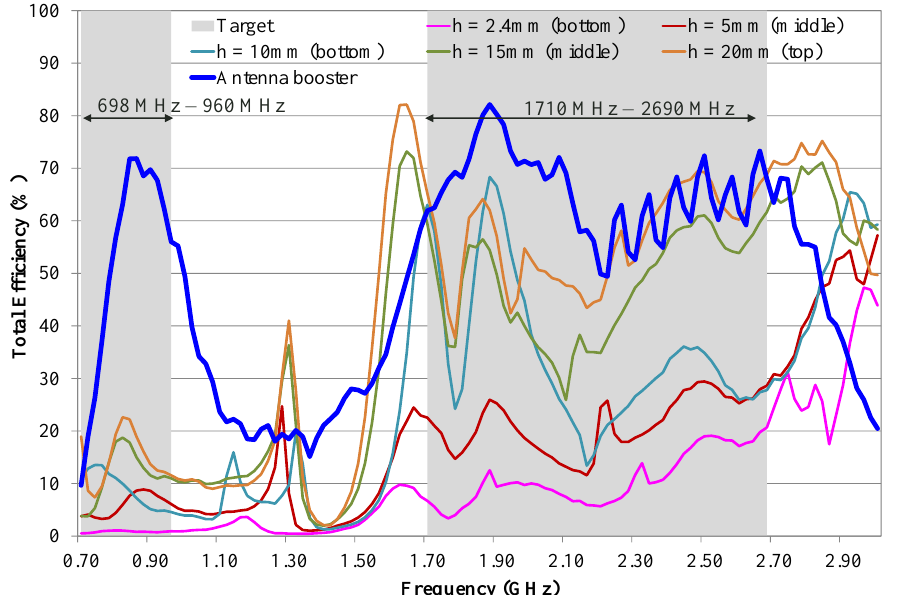
Figure 5. Measured total efficiency for the embedded antenna booster and the FPC antenna at different heights. Only the best efficiency among the three FPC positions (top, middle, and bottom) is shown for each